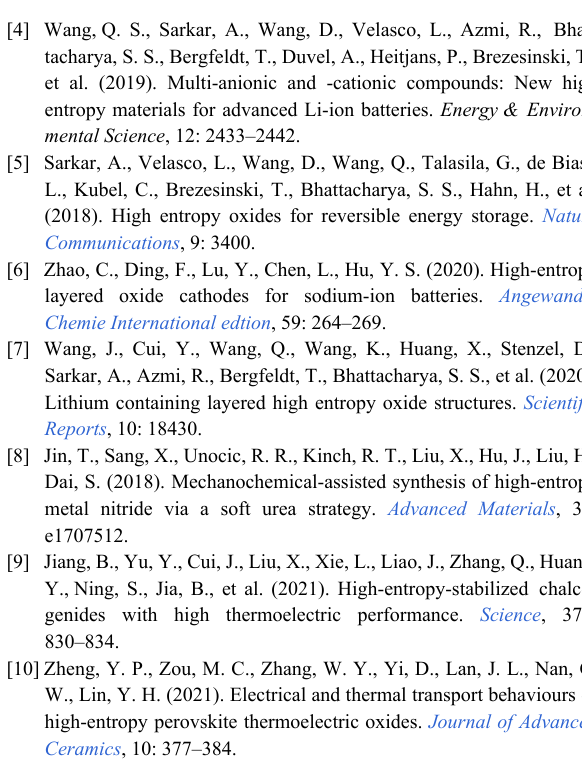
Fig. 2 Schematic diagram of high-entropy design strategy for local polymorphic distortion and giant energy storage performance. Reproduced with permission from ref. [2], © The